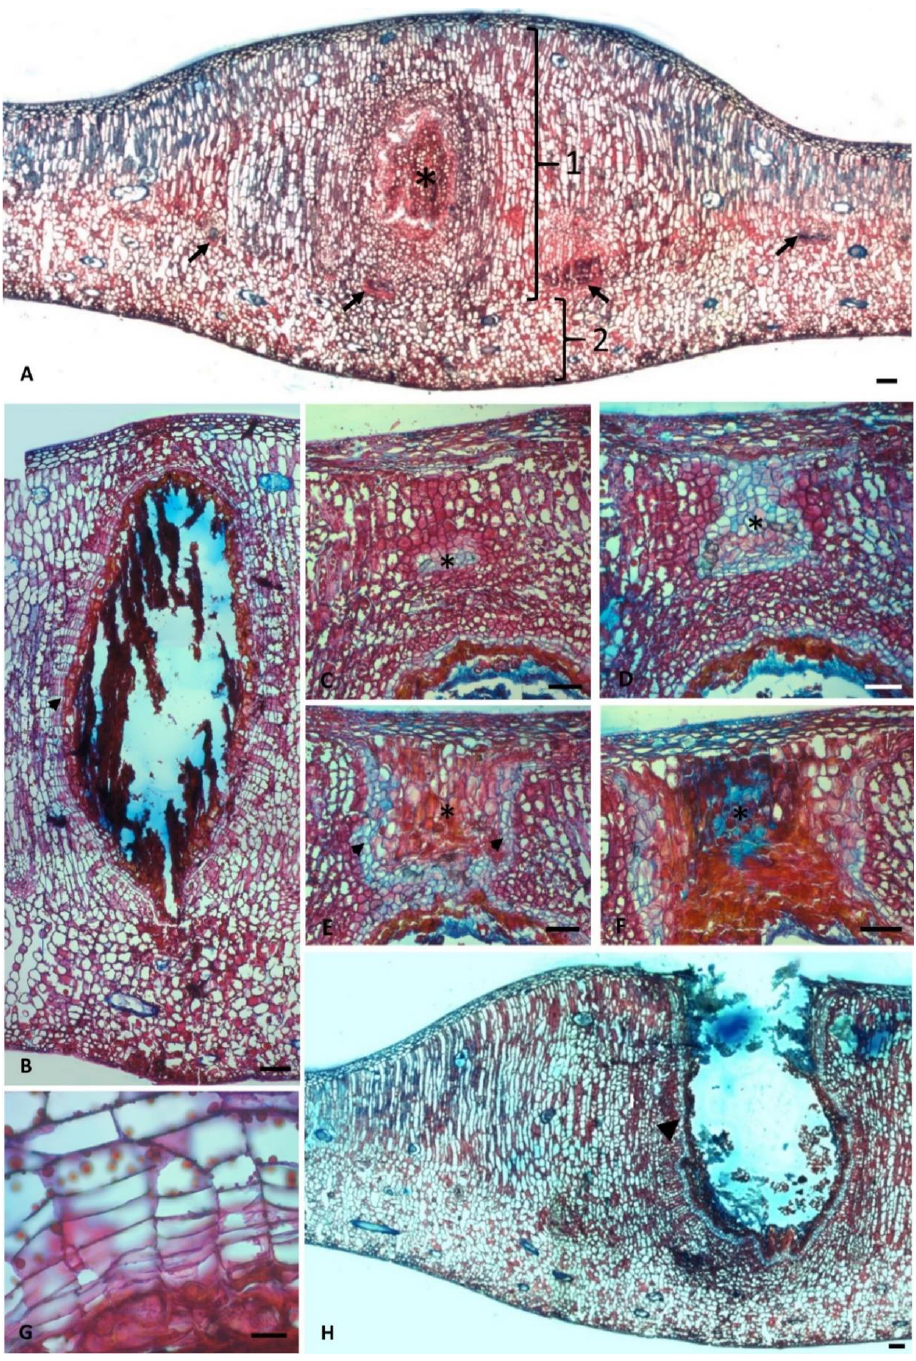
Figure 4. C. fluminensis. TS of galled leaves of male individuals. ( A ) Note the hypertrophy of the mesophyll, due to mainly the increase of palisade layers (1), whereas the spongy parenchyma (2) remains like the non-galled regions, but with flattened cells; several collateral bundles across the median region of the mesophyll (arrow), and the nutritive tissue from the larval chamber (*). ( B ) Larval chamber of mature gall. Note the organization of meristematic cells (arrow), continuously forming the nutritive tissue all around the larval chamber. ( C – F ) Progressive steps of the formation of the exit channel, through degeneration of parenchyma cells (*) between larval chamber and epidermis. Note the development of meristematic cells (arrow) stablished from the epidermis to the nutritive tissue, isolating the senescent tissues from the remaining tissues. ( G ) Details of the meristematic cells developed from the surrounding parenchyma cells that continuously form the nutritive tissue. ( H ) Senescent gall. Note the exit channel with degenerating cells and the meristem layers that isolate the exit channel from the remaining tissues. Bars: ( A ) = 200 µ m; ( B – F , H ) = 100 µ m; ( G ) = 20 µ